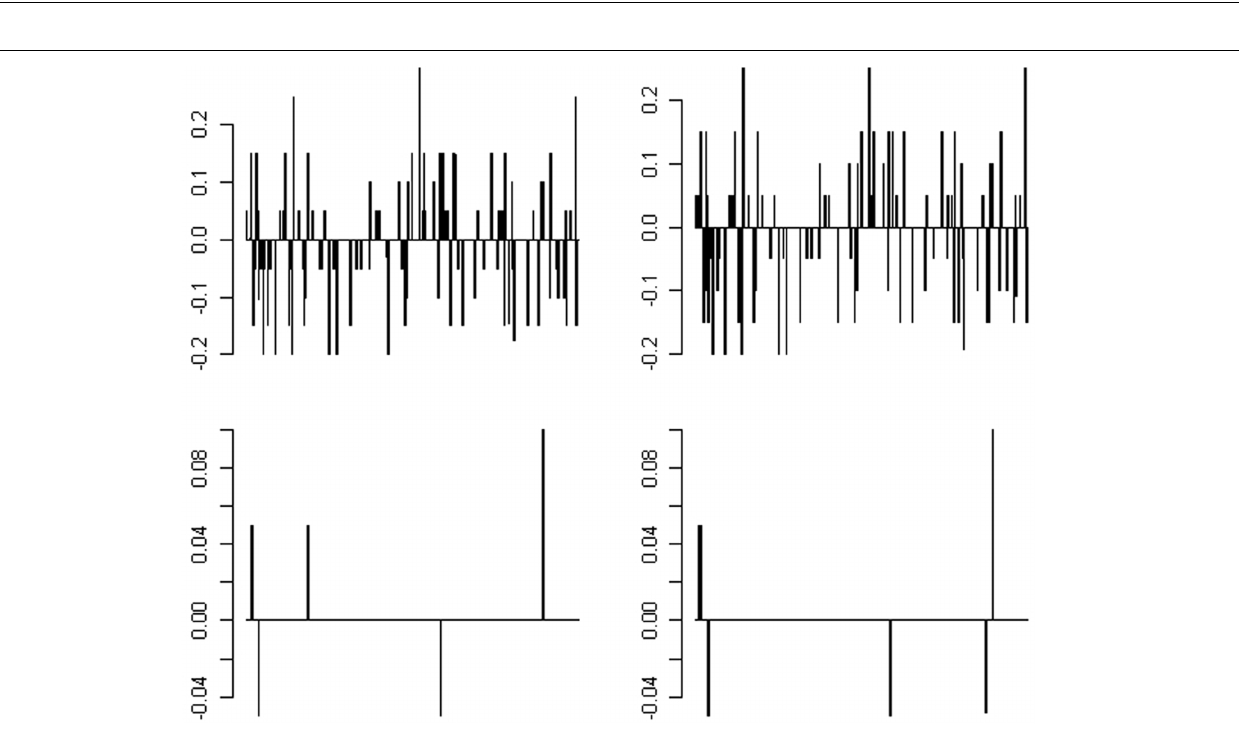
FIGURE 5 | Distribution of the difference between the estimated allele frequencies from pooled mtDNA sequencing and true allele frequency